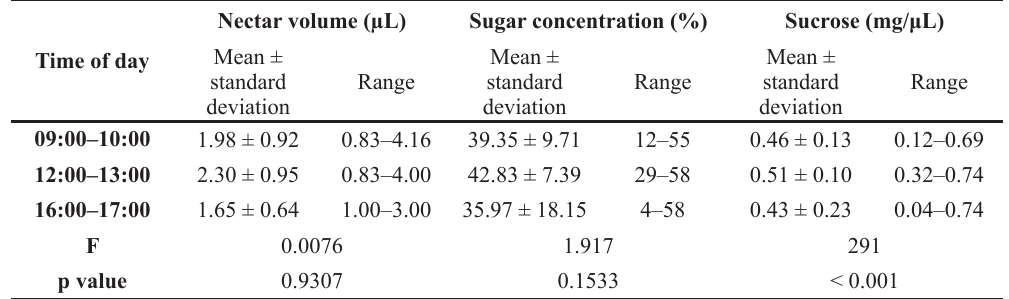
Table 3 – Nectar parameters in Campanula vardariana flowers (n = 30) measured during the day in the pollen presentation